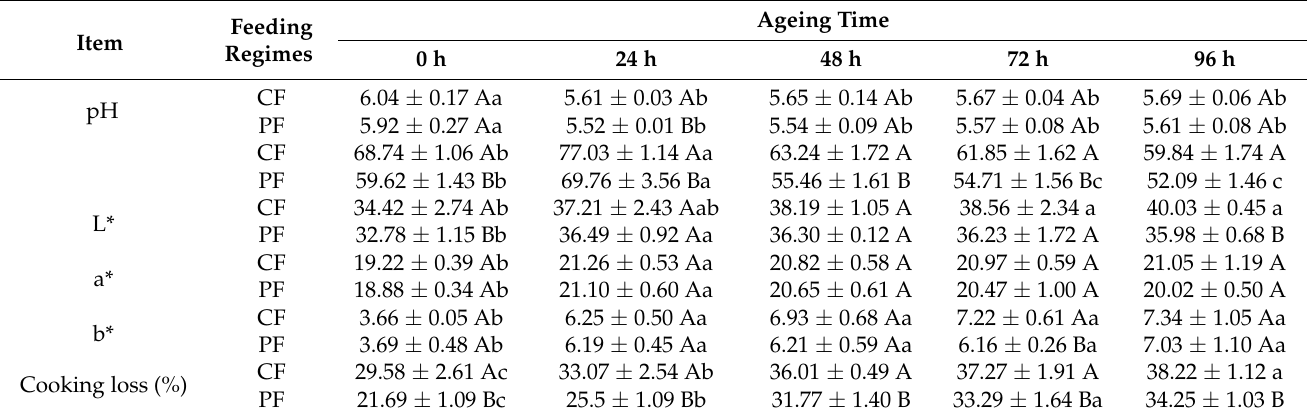
Table 2. Effects of different feeding regimes and postmortem aging times on the quality attributes in the LT muscles of sheep.